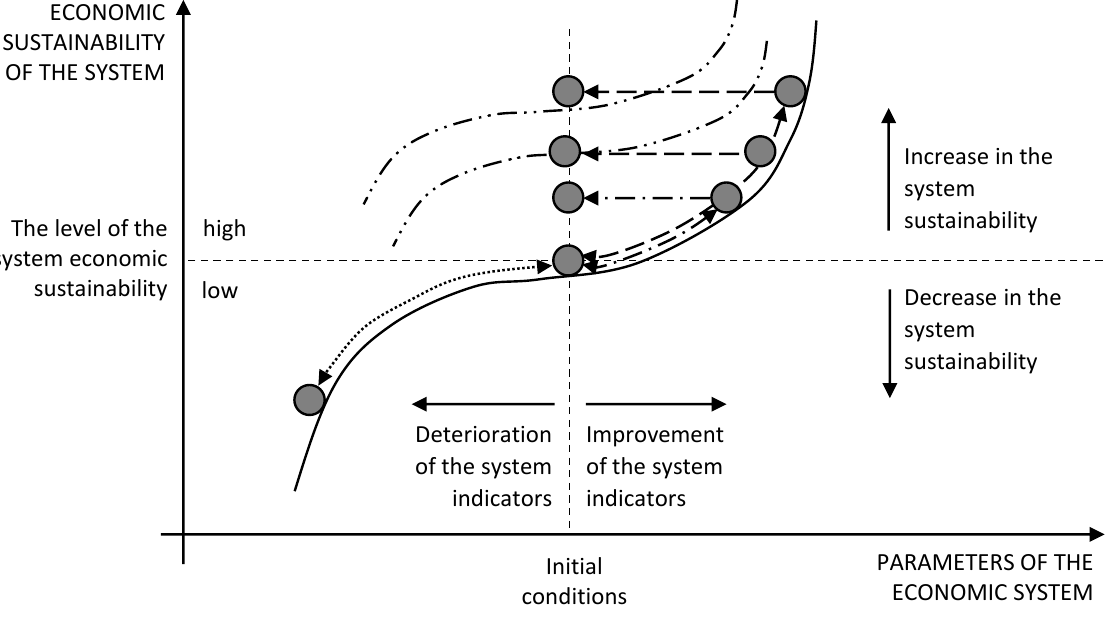
Figure 1. Graphic representation of the essence of the economic sustainability of the